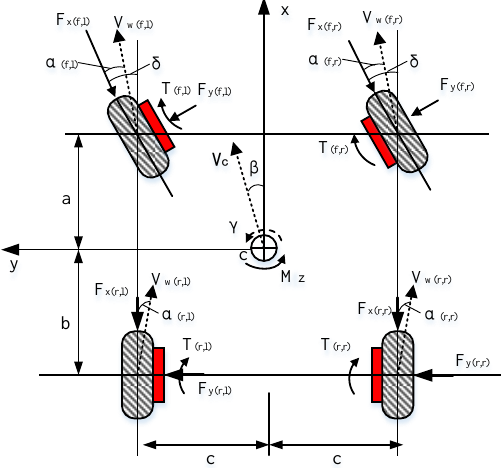
Figure 1. Coordinates for planar motions.